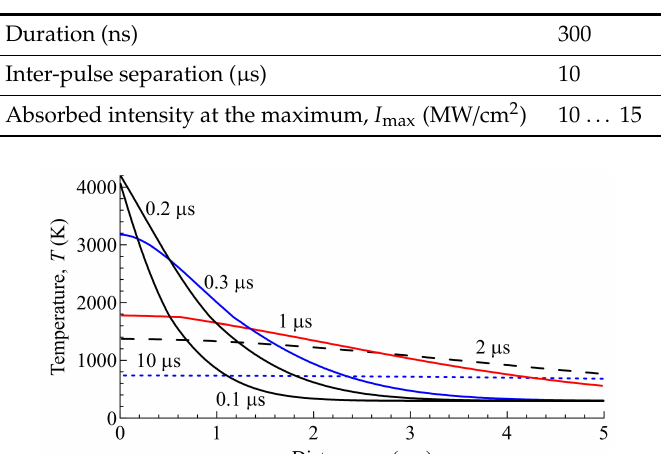
Figure 2. Temporal profiles of the absorbed laser power, the surface temperature, and the evaporation loss for a single pulse with I max = 15 MW / cm 2 . Table 3. Parameters of the laser pulse.